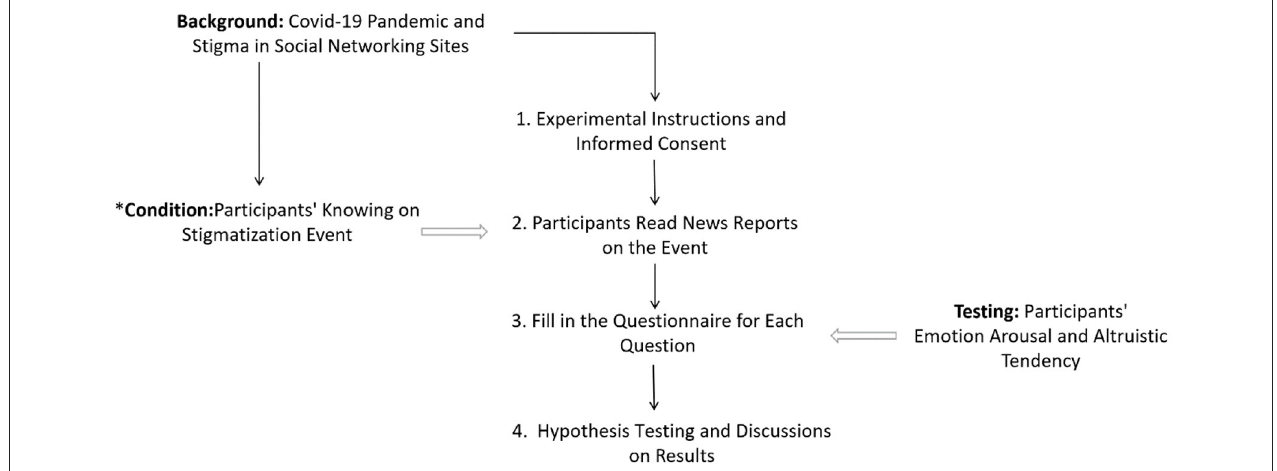
FIGURE 2 | Research design and experimental process. * Is a prerequisite for carrying out the research as well as a factor to be controlled and